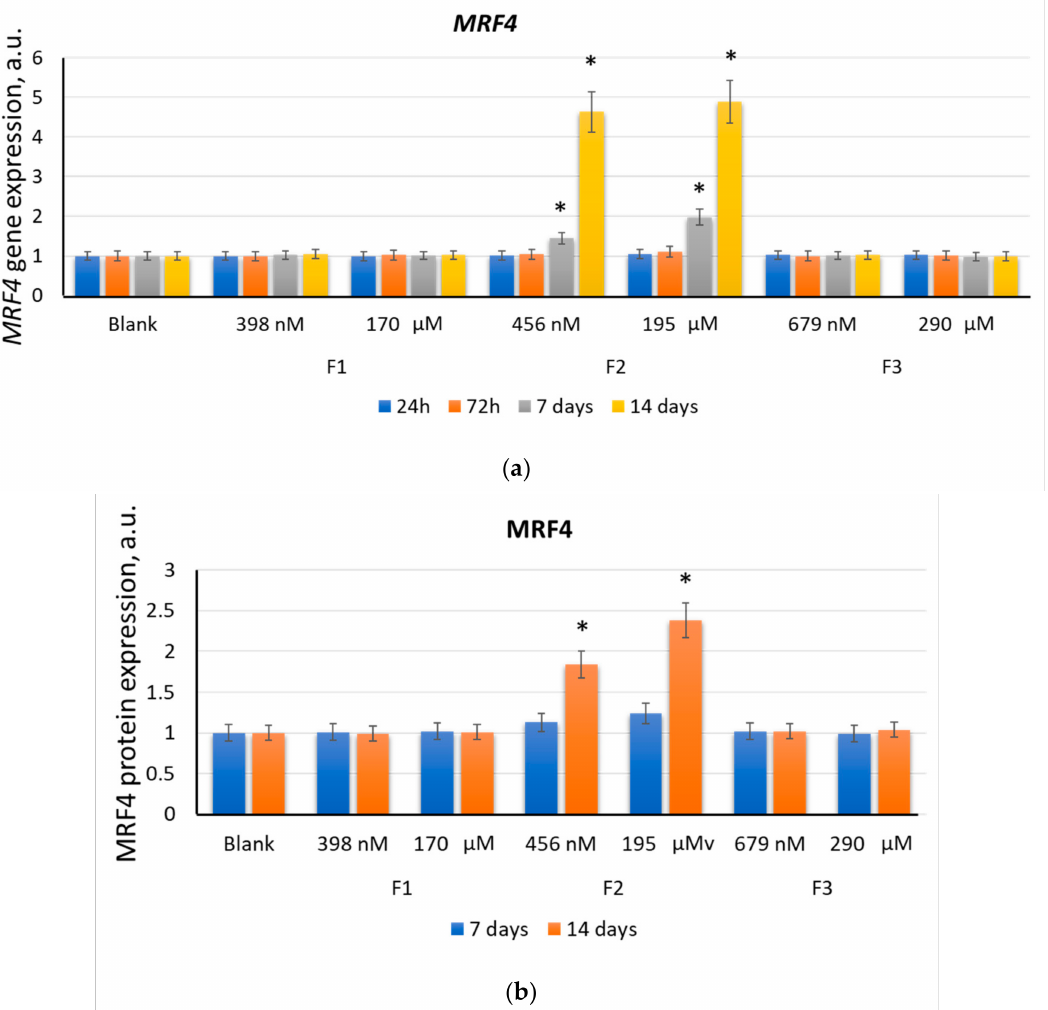
Figure 7. The effect of F1, F2, and F3 on the MRF4 gene expression ( a ) and MRF4 protein expression ( b ); the concentrations and exposition times are shown in the figure. The gene RNA amount was the mean value for three experiments related to the blank; the TBP gene was used as an internal reference gene; (*) denotes significant differences compared to blank cells, p < 0.005, in a Mann–Whitney test. In blank experiments, cells were incubated without the